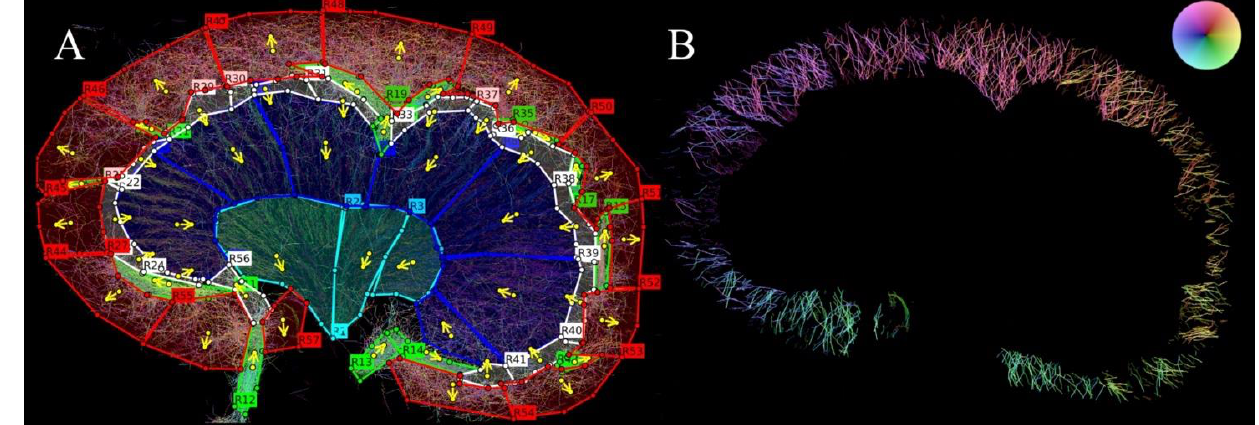
Figure 2. Illustration of the segmentation of a kidney from a 20-week-old obese Zucker rat. ( A ) Red segments define the cortex, the dark blue the outer medulla, the light blue the inner medulla, and the green the larger vessels. The larger vessels were not included in the quantifications of density and tortuosity. The white segments in the sub-cortex were not taken into consideration, since it was difficult to determine whether the tracks in these regions were part of the cortex or the outer medulla. The arrows define the direction of the flow in the regional arteries/arterioles. ( B ) Cortical artery/arteriole tracks after vessel separation. The color of the wheel in the top right corner indicates the flow direction.